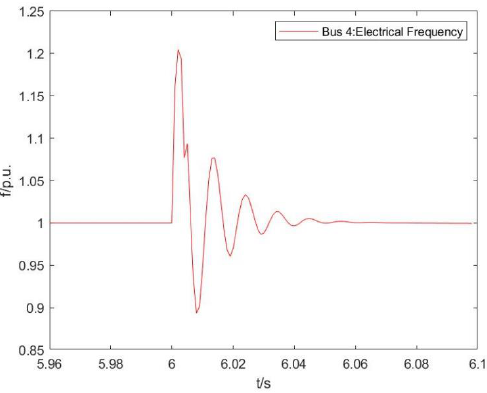
Figure 19. Response characteristics of frequency (consider VSG and collaborative control).